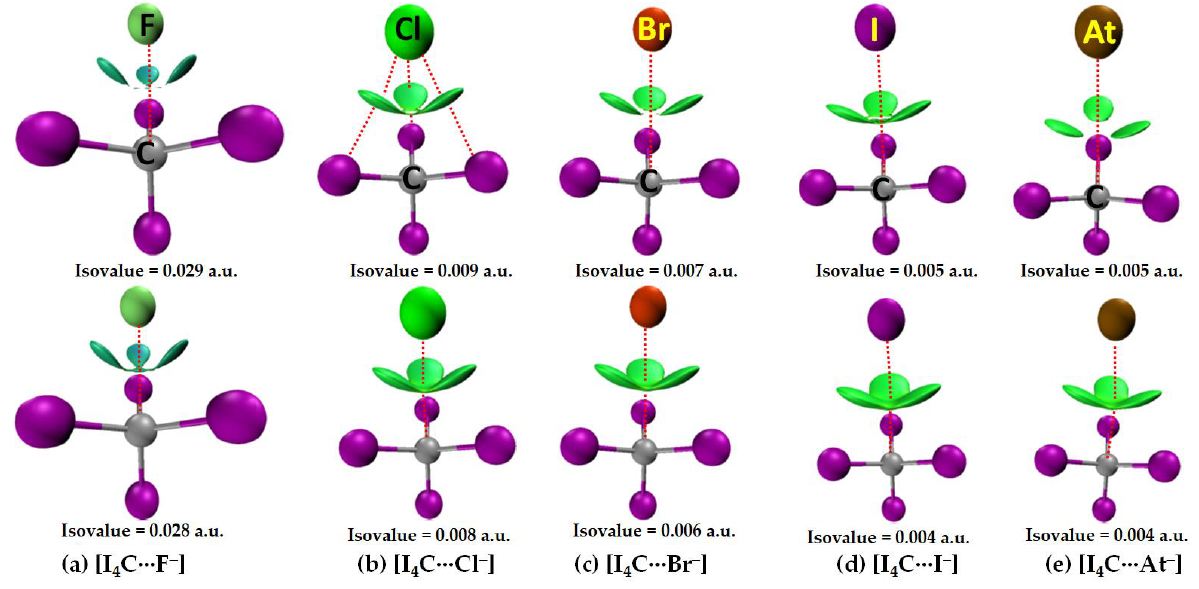
Figure 9. ( a – e ) [ωB97X -D/def2-QZVPPD] level IGM- δg inter -based isosurface (bluish-green or green volumes) plots of [I 4 C···X − ] (X = F, Cl, Br, I, At), showing possible I···X halogen bonded and C···X tetrel bonded interactions between interacting molecular entities. (Top) Illustration of I···X Type-I halogen-halogen bonded interactions between the interacting units that appear with larger isovalues. (Bottom) Illustration of C···X tetrel bonded interactions between the interacting units that appear at smaller isovalues. Anion derivatives are labeled. The [I 4 Si···X − ] systems feature very similar IGM- δg inter -based isosurfaces, Figure 10. That is, a very large isovalue was necessary to reveal sizable isosufaces describing the dative tetrel bond in [I 4 Si···F − ] and [I 4 Si···Cl − ], whereas a potentially small isovalue was required to visualize the isosurface domains in [I 4 Si···X − ] (X = Br, I, At). The view is also transferable to the [I 4 Ge···X − ] systems (not shown).